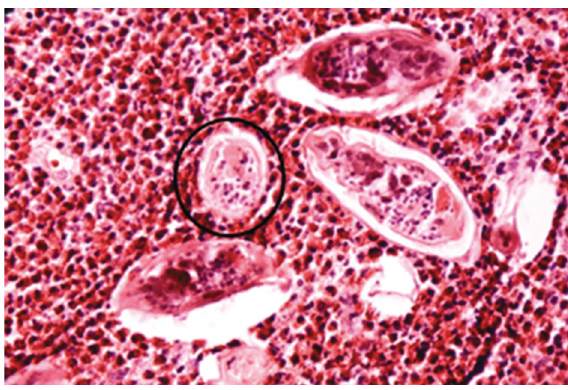
Figure 1: Illustration of the Schistosoma mansoni